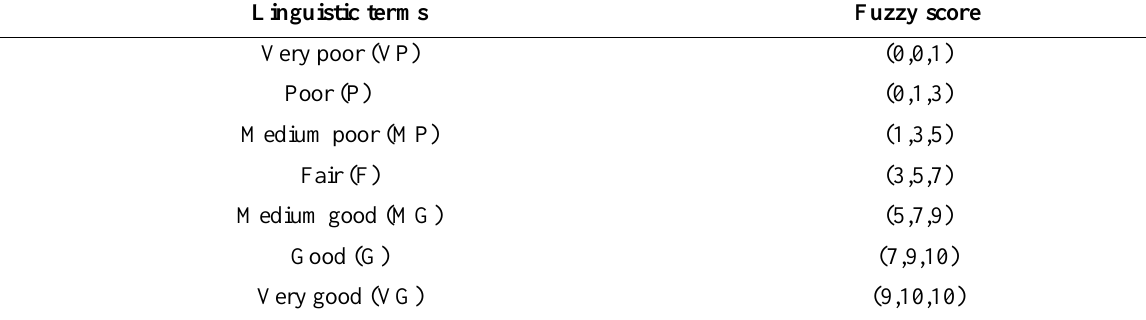
Table 5. Fuzzy evaluation scores for alternatives (system